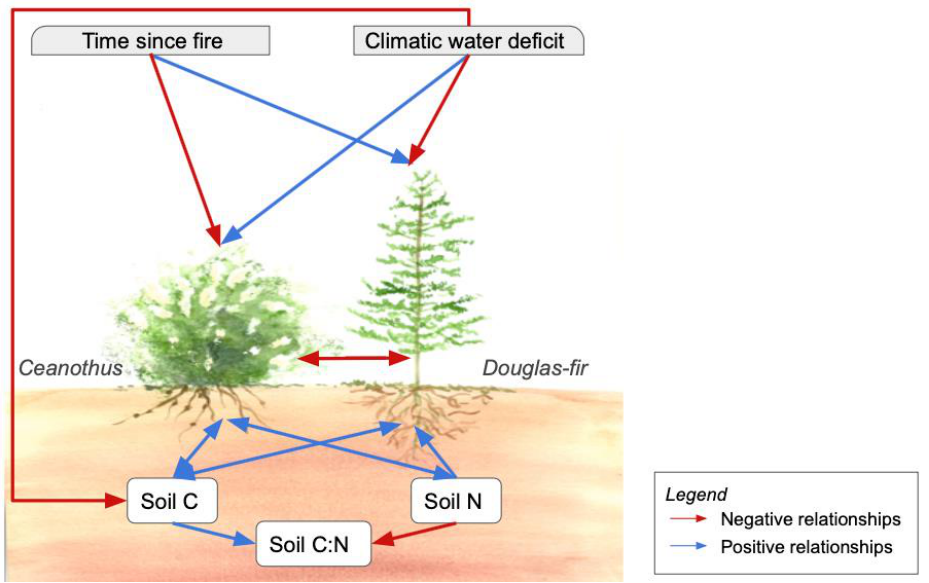
Figure 1. Schematic diagram of relationships between Ceanothus spp. and Douglas-fir. Line color specifies positive (blue) and negative (red) relationships. Double headed arrows show reciprocal relationships.